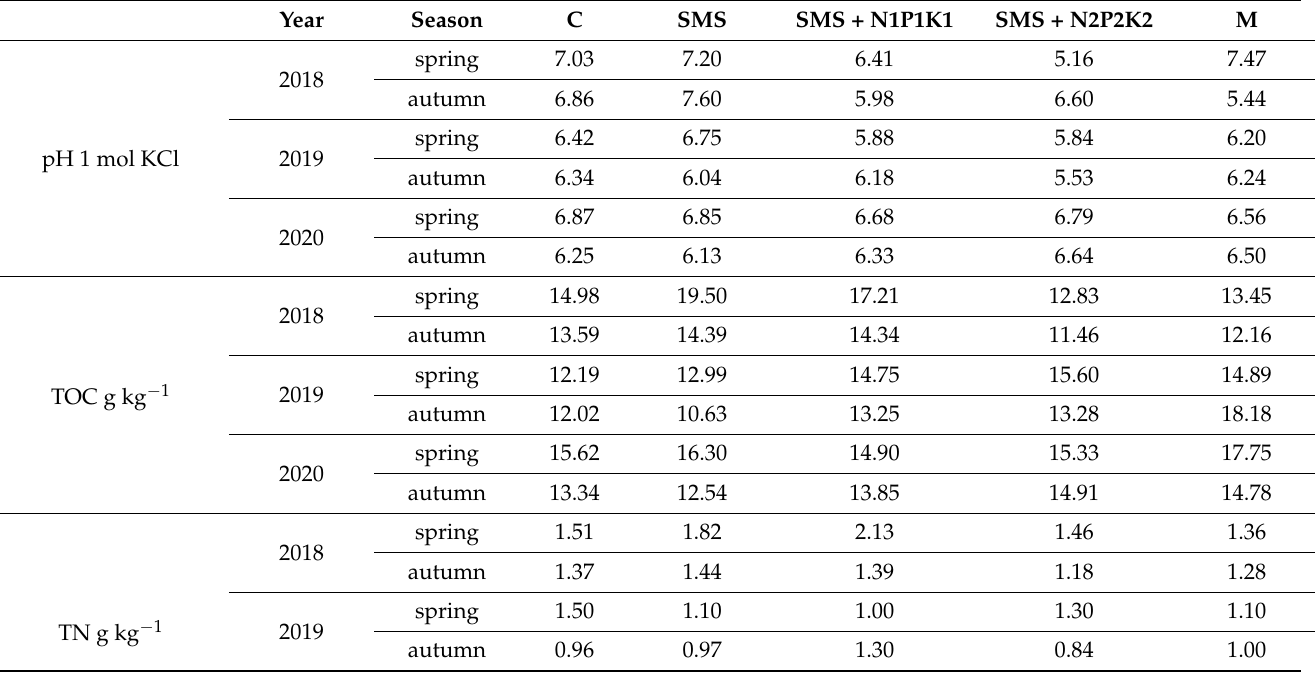
Table 2. Selected, physico-chemical and chemical properties of the